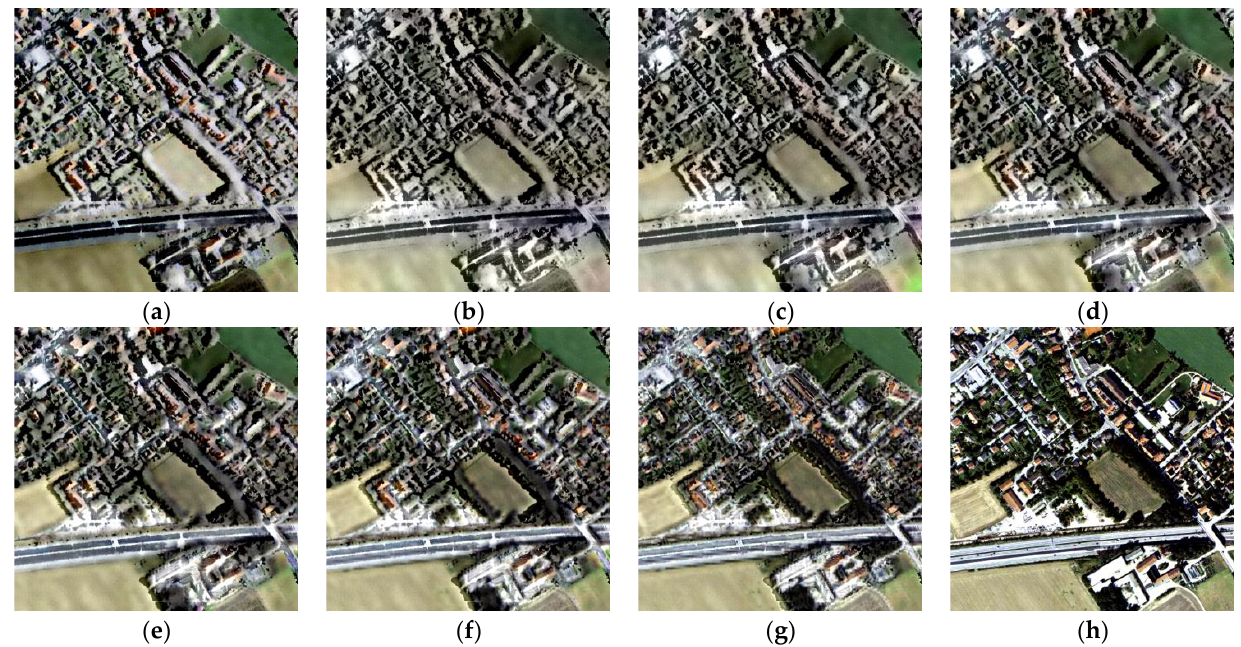
Figure 9. Fusion results of adjustability experiment in area 1. ( a ) IHS fusion; ( b ) LPSR-5; ( c ) LPSR-4;